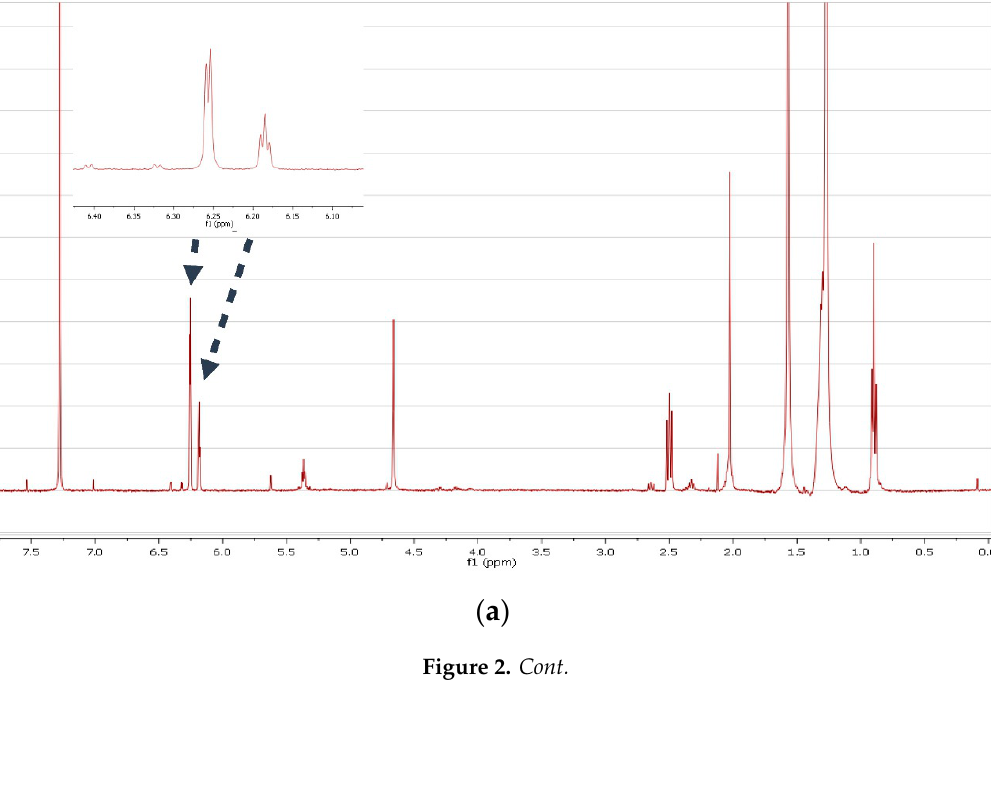
Figure 1. 1 H-NMR spectra in DMSO-d 6 of flour extracts. The highlighted peak corresponds to the total 5-alkylresorcinols.